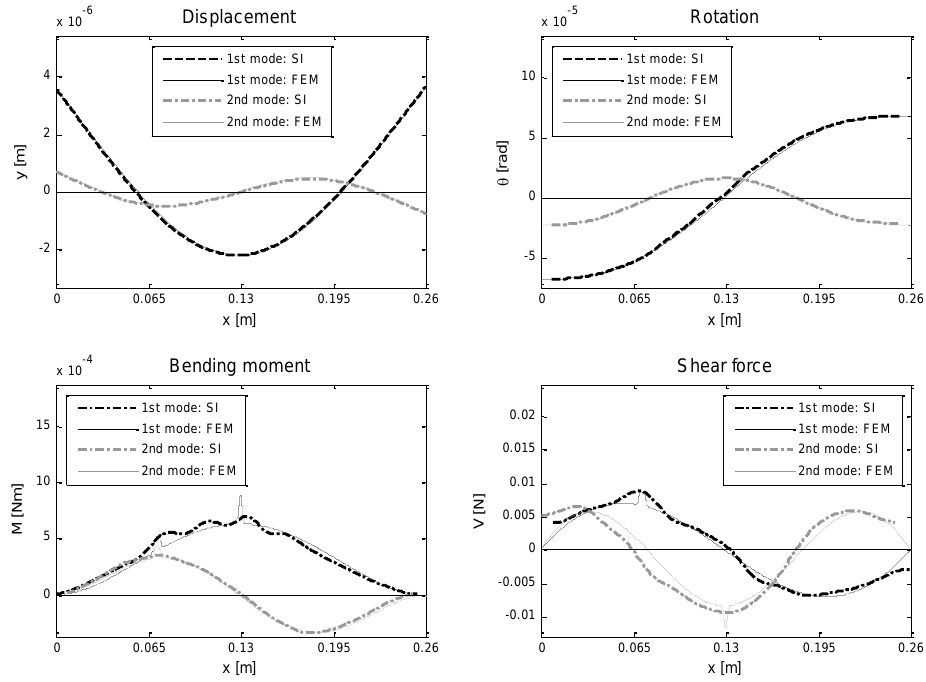
Fig. 4. Displacement and rotation fields, bending moments and shear force distributions of damaged beam using the pulsed shear interferometric system (SI) and the finite element method (FEM) for the fourth damage